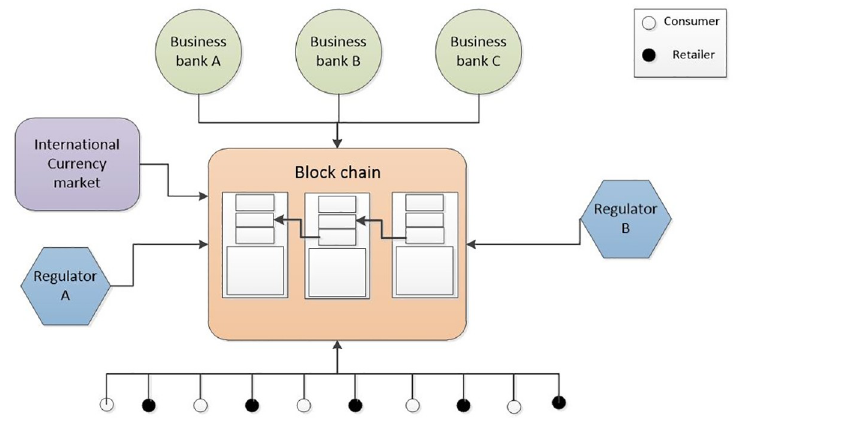
Fig 2. The framework of cross-border